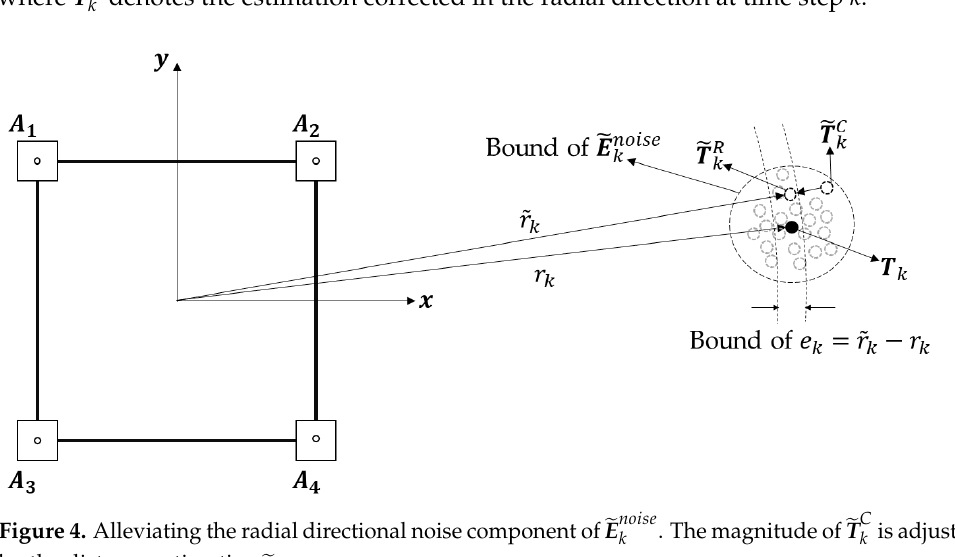
Figure 4. Alleviating the radial directional noise component of 𝑬̃ 𝑘𝑛𝑜𝑖𝑠𝑒 . The magnitude of 𝑻̃ 𝑘𝐶 is ad- justed by the distance estimation 𝑟̃ 𝑘 .